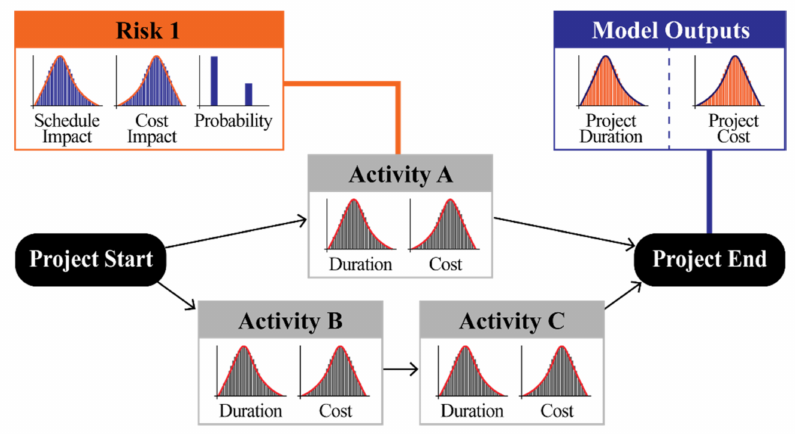
Figure 2. Monte Carlo (MC) simulation experiment for risk